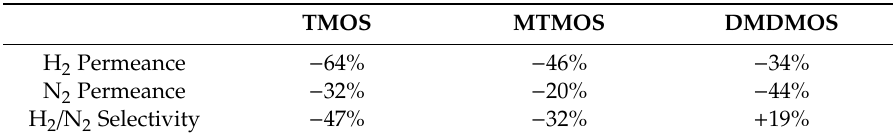
Table 4. Summary of the percentage change of the TMOS-, MTMOS-, and DMDMOS-derived membranes after 96 h exposure to 16 mol.% H 2 O at 650 ◦ C. TMOS